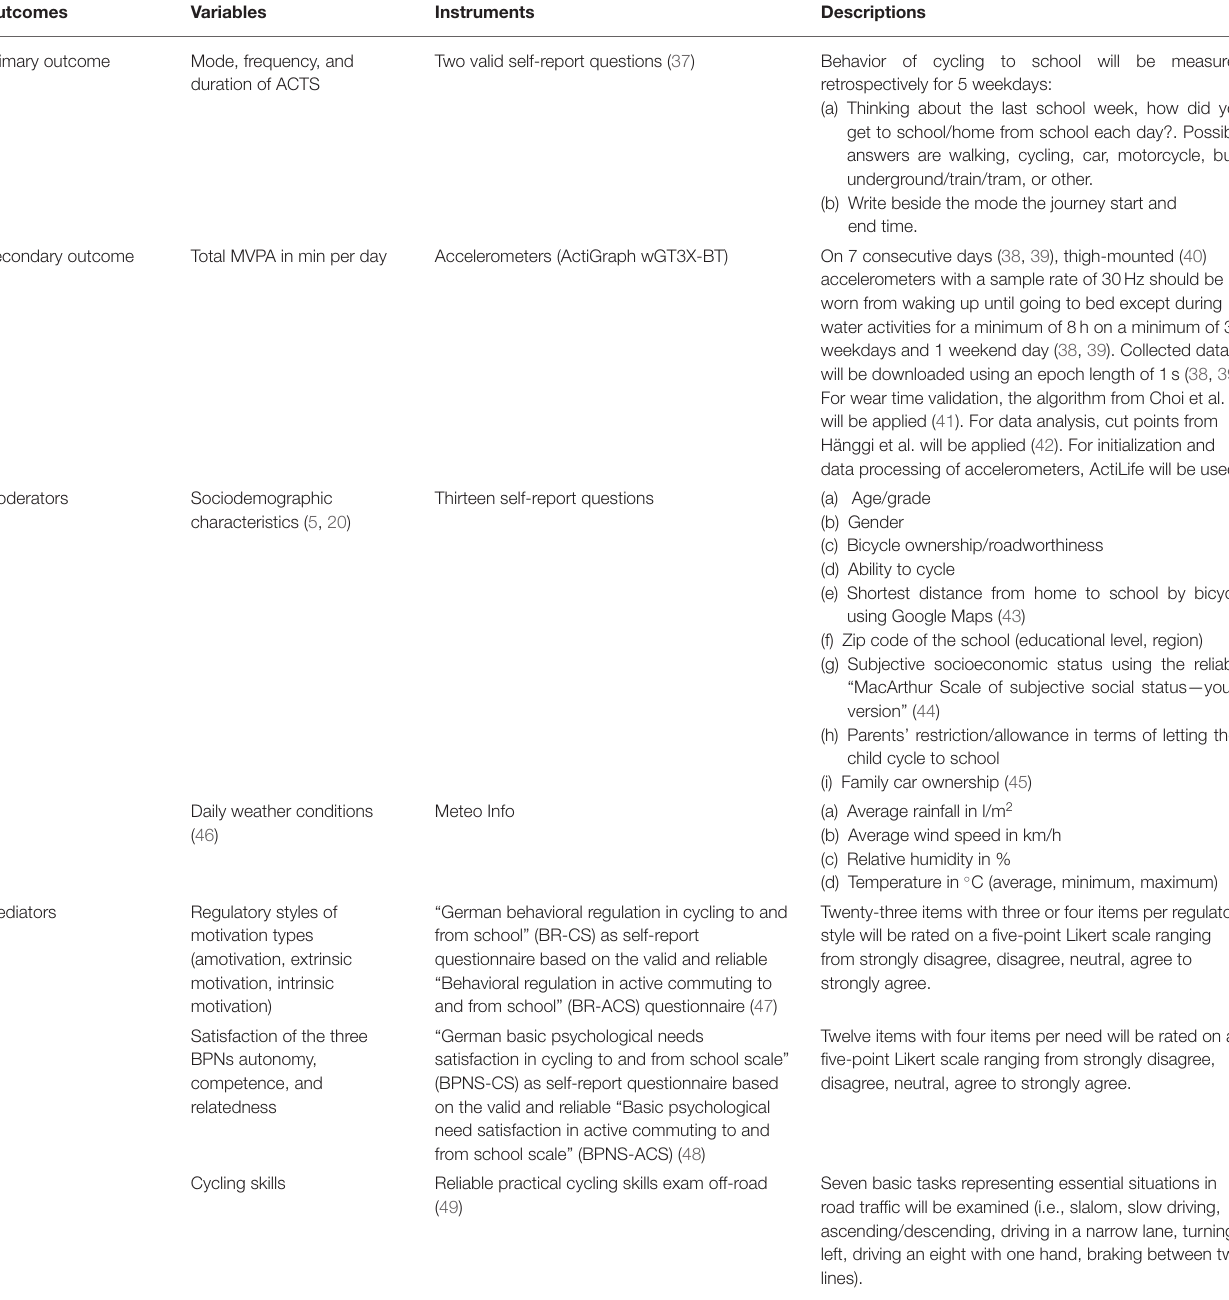
TABLE 4 | Measuring instruments for the effect